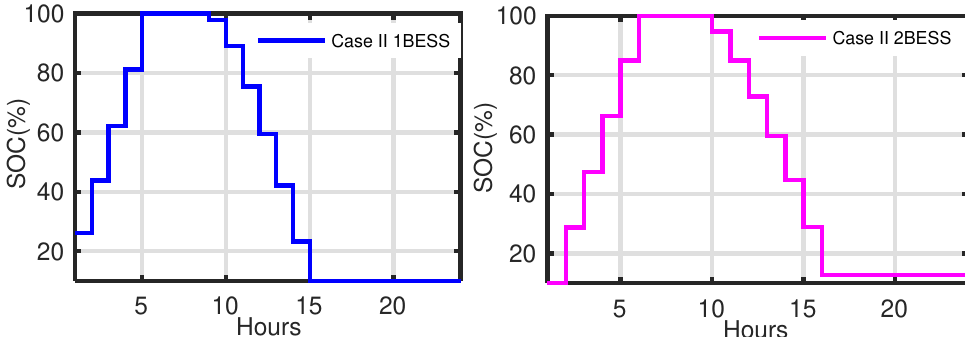
Figure 6. Hourly (%) of SOC for ( a ) I BESS, and ( b ) II BESS for Case II.